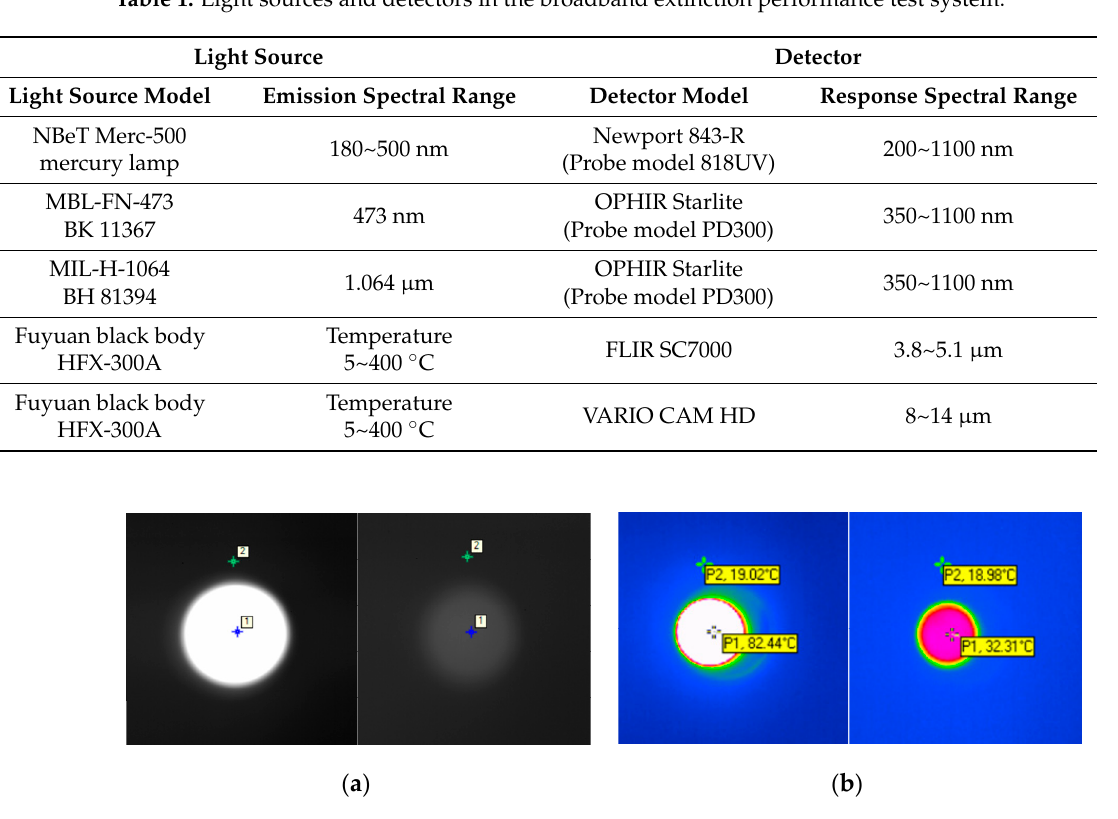
Figure 7. MIR and FIR thermal images before and after bioaerosol release. ( a ) MIR thermal images before and after bioaerosol release; ( b ) MIR thermal images before and after bioaerosol release.